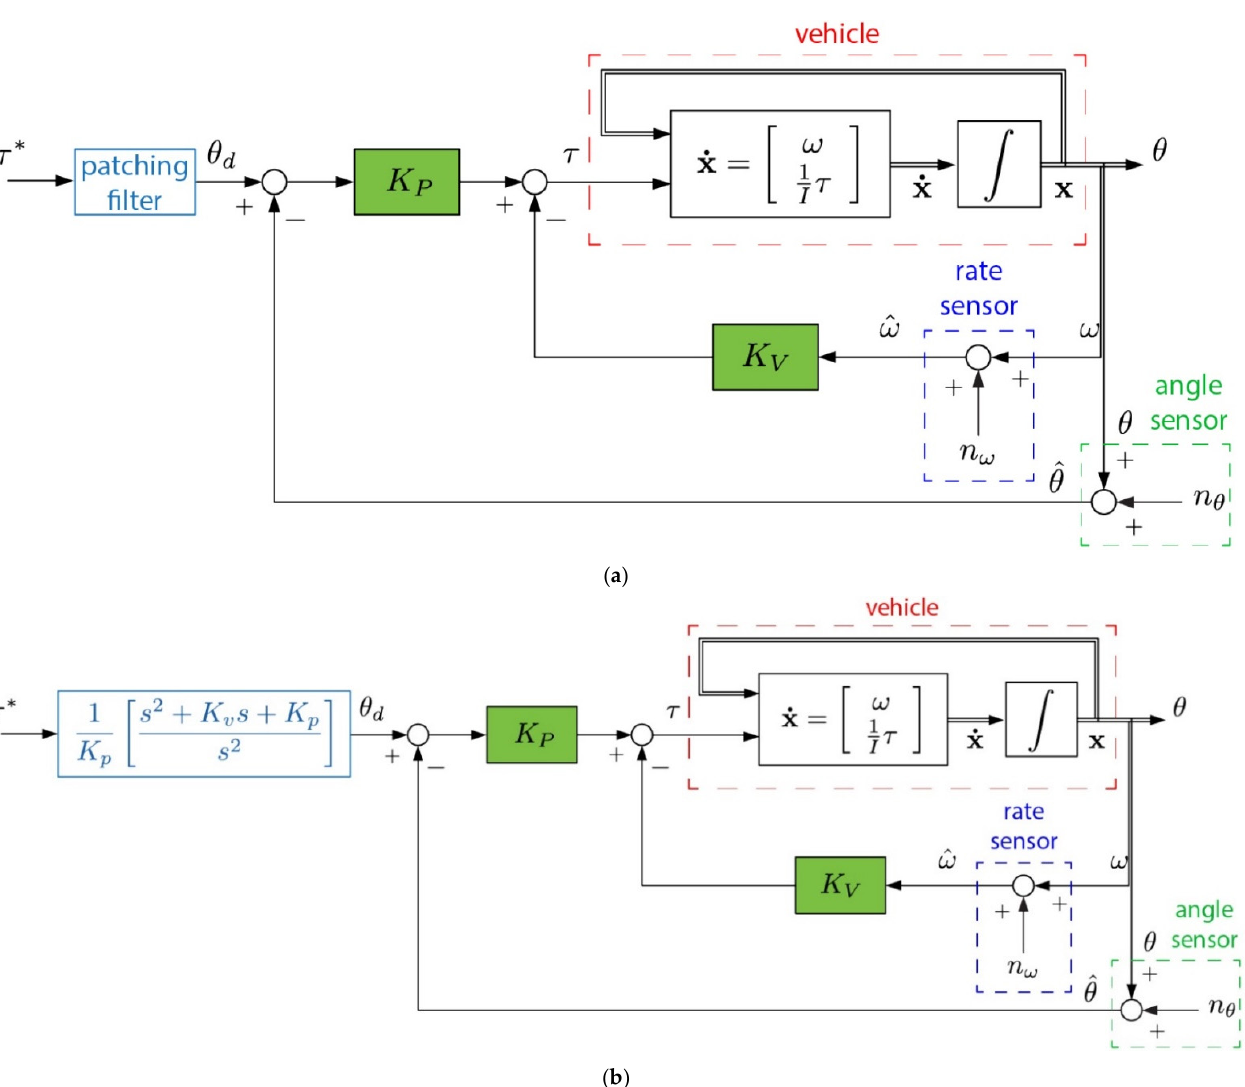
Figure A2. Inducing improvements: elaborating the so-labeled block in Figure A1a. ( a ) architecture with Double Integrator Patching Filter ( b ) architecture with System Inverting Patching Filter